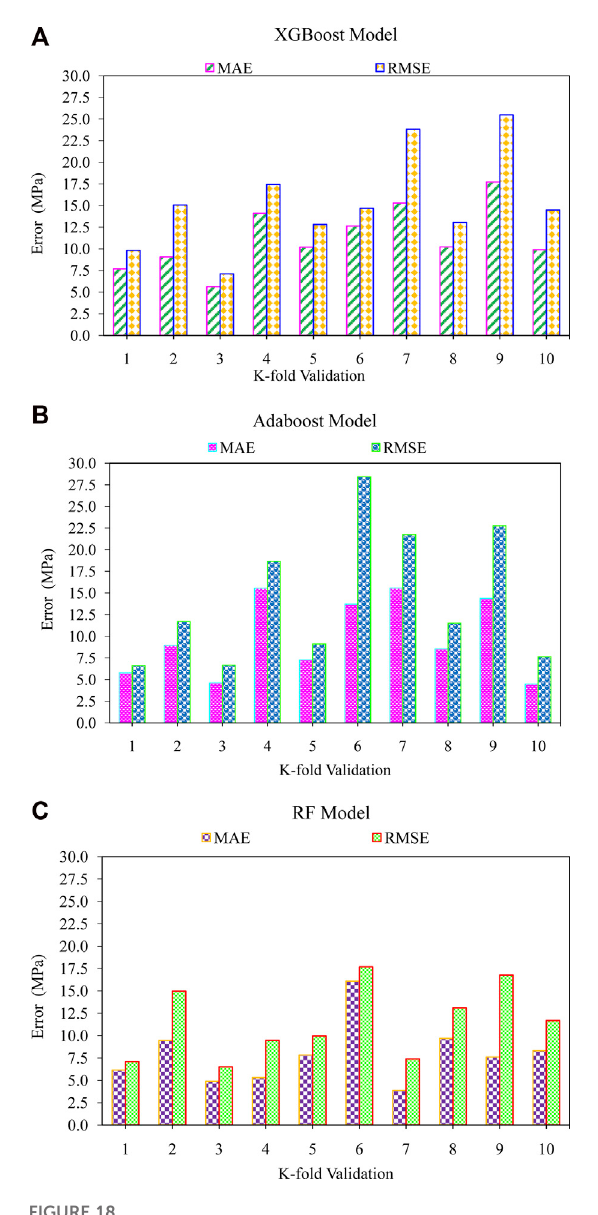
FIGURE 18 Statistical analysis: (A) XGBoost; (B) Adaboost; (C)